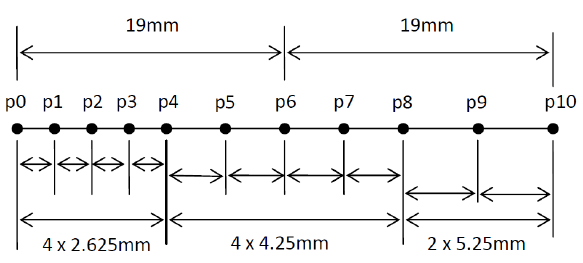
Figure 7: Locations of points p0, p1,..., p10 along the diaphragm, where the pressure evolution was computed for each of the cases containing two bluff bodies in tandem. Point p6 is the center S of the diaphragm.